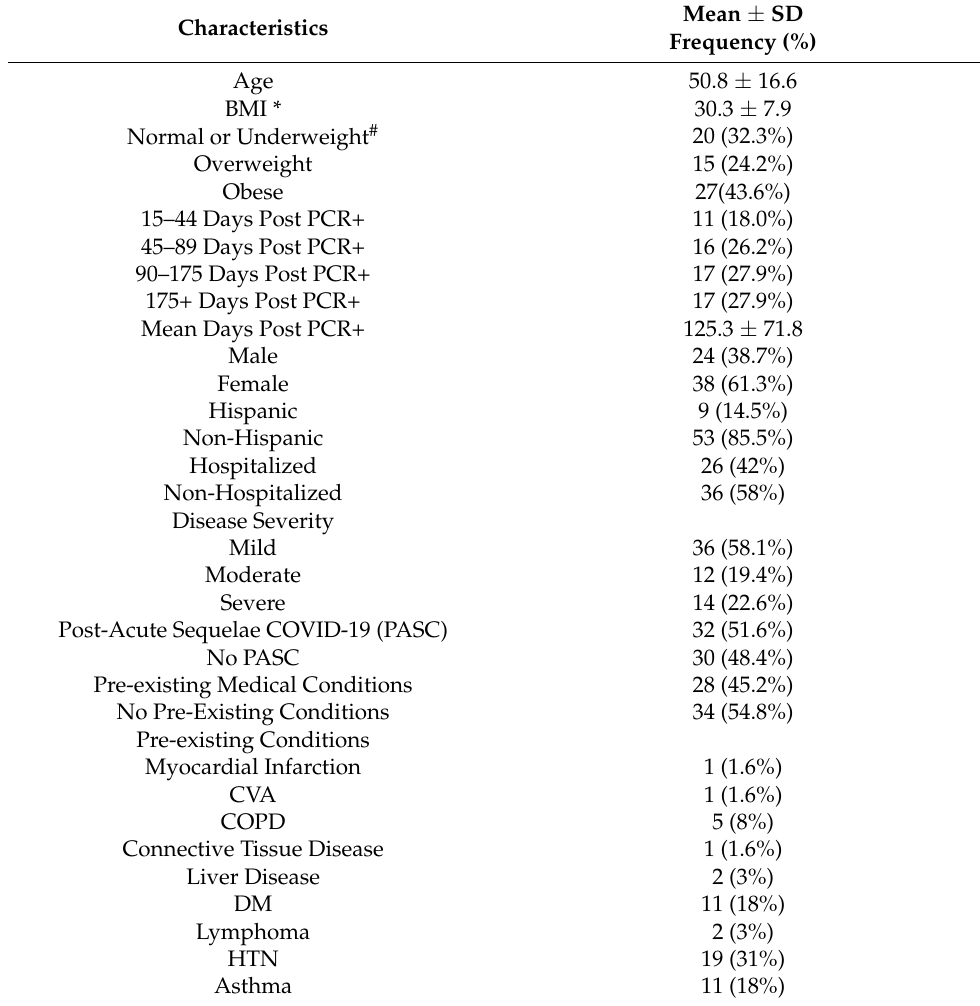
Table 1. Demographics of COVID-19 adult participants that completed the Rand